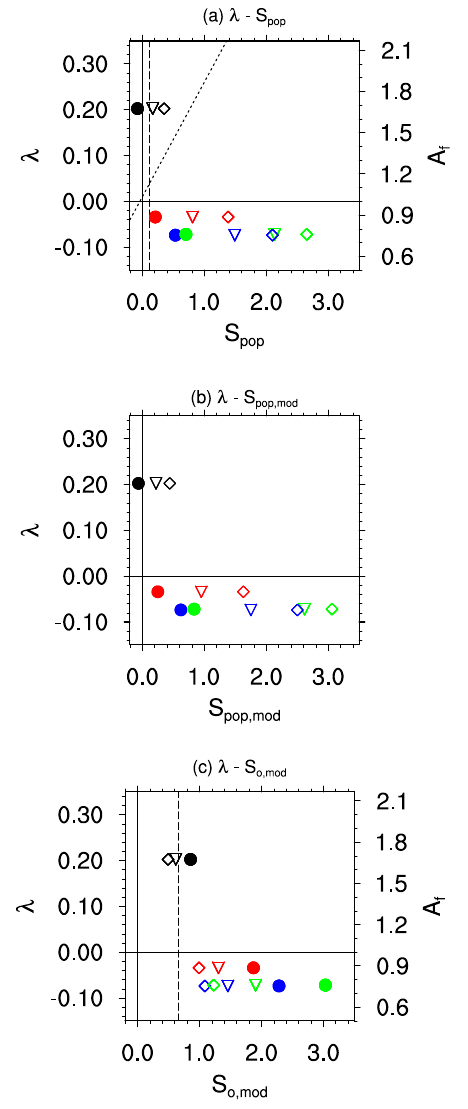
Figure 7. (a) λ (and A f ) vs. S pop , (b) λ vs. S pop,mod , and (c) λ vs. S o, mod for the RICO simulations from Jiang et al. (2010). The colors correspond to increasing N a from 100mg − 1 to 200 (black), 300 (red), 400 (blue), and 500 (green)cm − 3 . The symbols denote the different thresholds used to conditionally average R and POP, i.e., T h = 0 . 001 (closed circle), 0.5 (downward-pointing triangle), and 5 (diamond)mmday − 1 . In (a) , the thin dashed line shows the linear relationship determined by Wang et al. (2012) for the λ – S pop relationship, while the vertical dashed line corresponds to the satellite-measured value of S pop , i.e., 0.12 (Wang et al., 2012). In (c) , the vertical dashed line denotes the surface-based estimate of S o, mod , i.e., 0.66 (Mann et al., 2014).